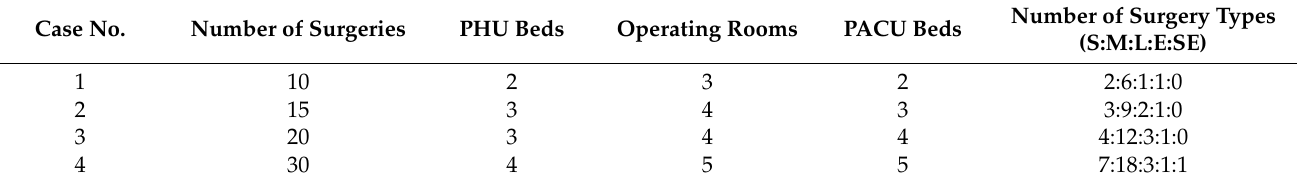
Table 4. The detailed information of four test cases.